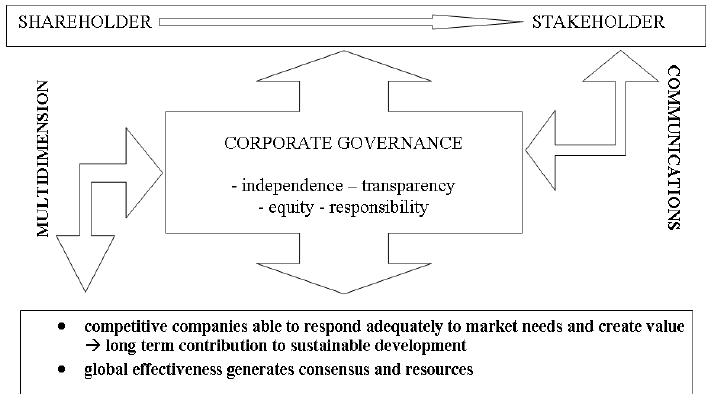
Figure 2: Effectiveness Conditions for Corporate